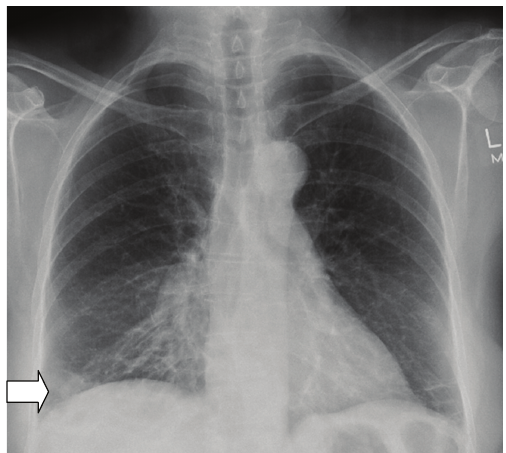
Figure 1: PA chest X-ray showing ill-defined opacity right lower zone (arrow).